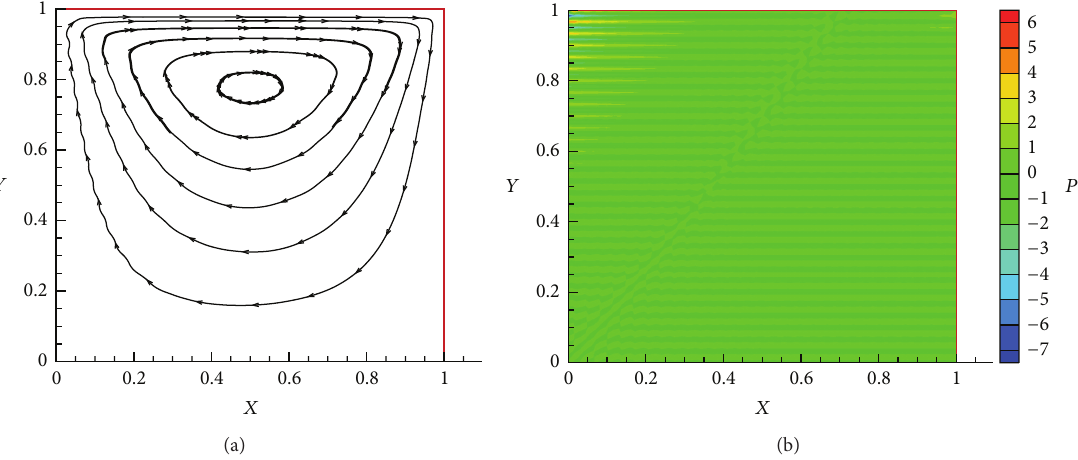
Figure 2: Velocity streamlines (a) and pressure level lines (b) for the regular method with 𝜀 = 1.0𝑒 − 6 , 𝛼 = 100 , and 𝑟 = 4 , respectively.